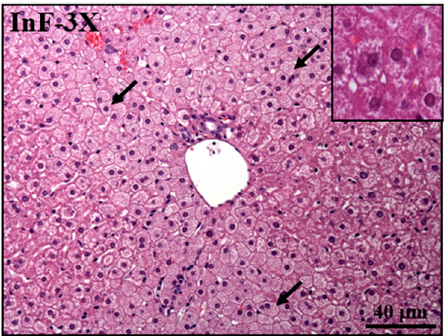
Figure 7. Effect of eight-week InF supplementation on the pathology of liver tissues in hyperlipidemic hamsters. Arrows indicate microvesicular fat droplets. Specimens were photographed by light microscopy. (H and E staining, magnification: ×200, Scale bar, 40 μ m).